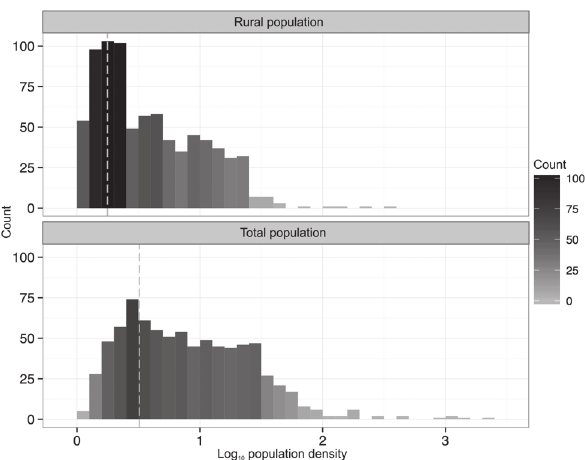
Figure 2. Frequency distribution of the rural and total population density (inhabitants per km 2 log ) from the 807 municipalities within 10 the Legal Brazilian Amazon’s nine states (Acre, Amapá, Amazonas, Pará, Rondônia, Roraima, Tocantins, Mato Grosso, and Maranhão) for 2010 (IBGE 2010). Vertical dashed lines indicate the rural and total population densities (log ) of our study 10